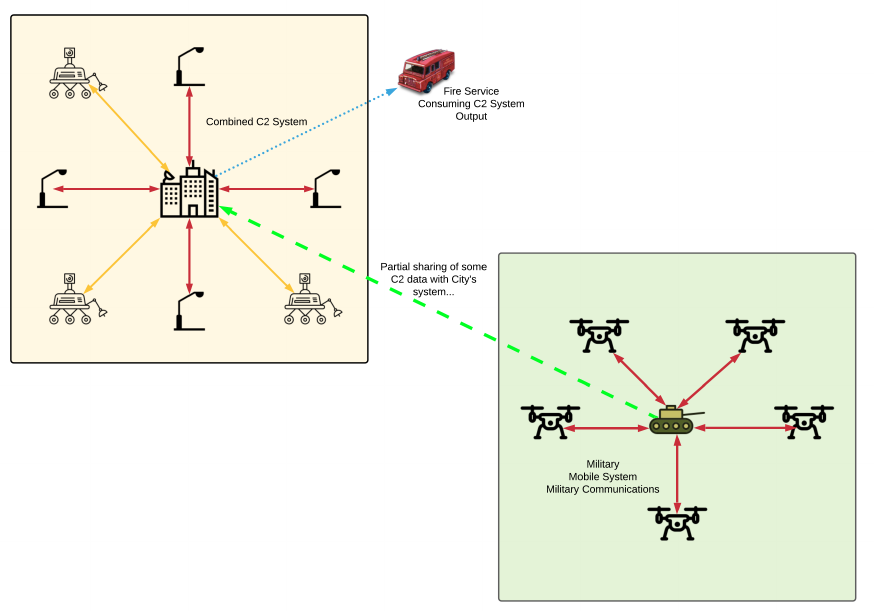
Figure 3. A depiction of the idealized data sharing relationship between a smart city C2 system and the sensors provided as a part of military assistance to the civil